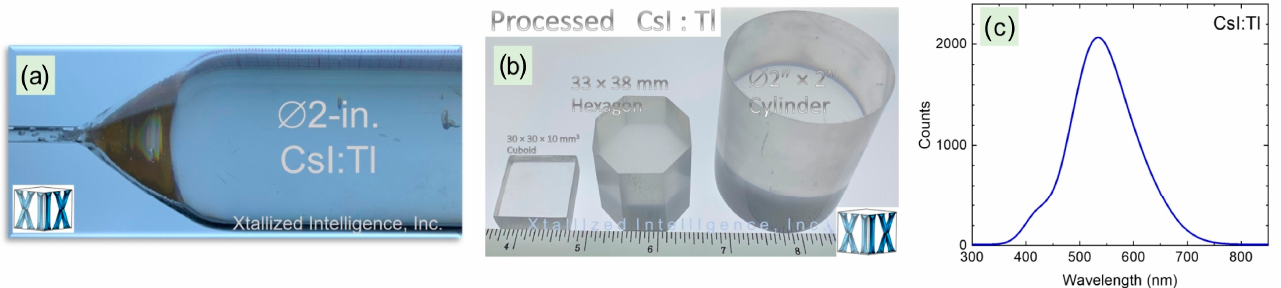
Figure 1. ( a ) A ∅ 2-in. CsI:Tl crystal boule grown at XI, Inc. ( b ) CsI:Tl samples of various shapes and sizes cut and processed from the boule in ( a ). ( c ) X-ray excited luminescence spectrum of CsI:Tl.